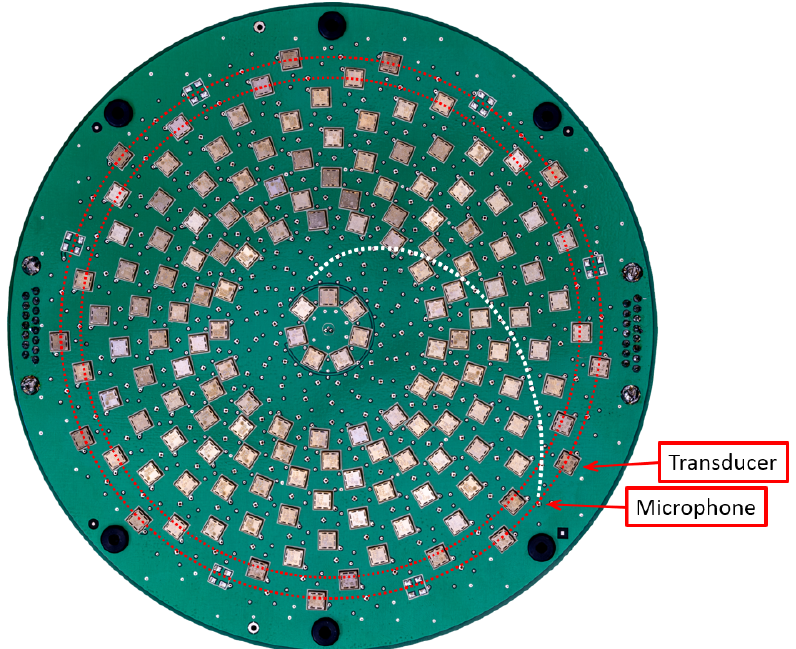
Figure 2. Photo of the ultrasonic array’s main PCB (printed circuit board). The transducers (silver squares) and microphones (located behind holes) are arranged in a multiarm spiral pattern forming rings. One of the microphone spirals arms is illustrated by a white dashed line while the two outer rings of microphones and transducers are shown as red dashed